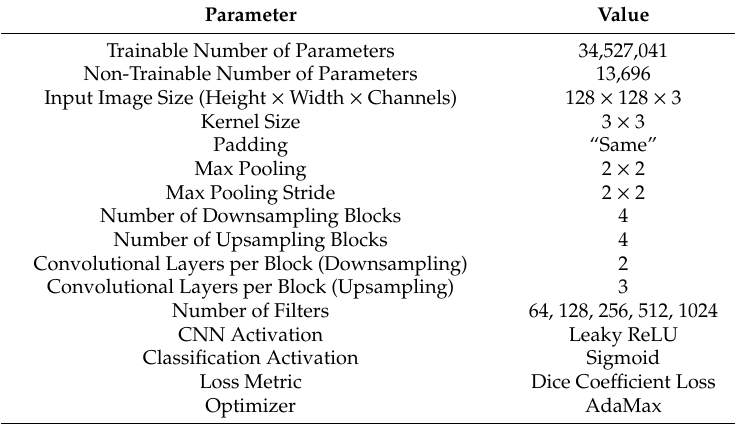
Table 2. Semantic segmentation algorithm architecture used in this study and modified from